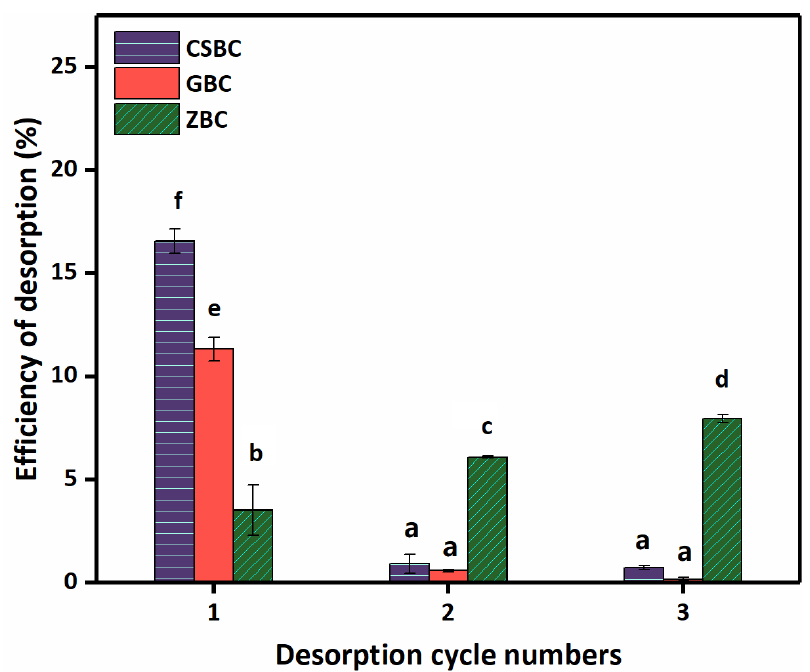
Figure 8. Effects of desorption of P by CSBC, GBC, and ZBC. (Adsorbent dose: 5 g L − 1 ; P initial concentration: 15 mg L − 1 ; adsorption time: 24 h; pH: 6; temperature: 25 °C; ionic strength: 0.01 M; desorption concentration: 0.1 M NaCl; desorption time: 24 h.)